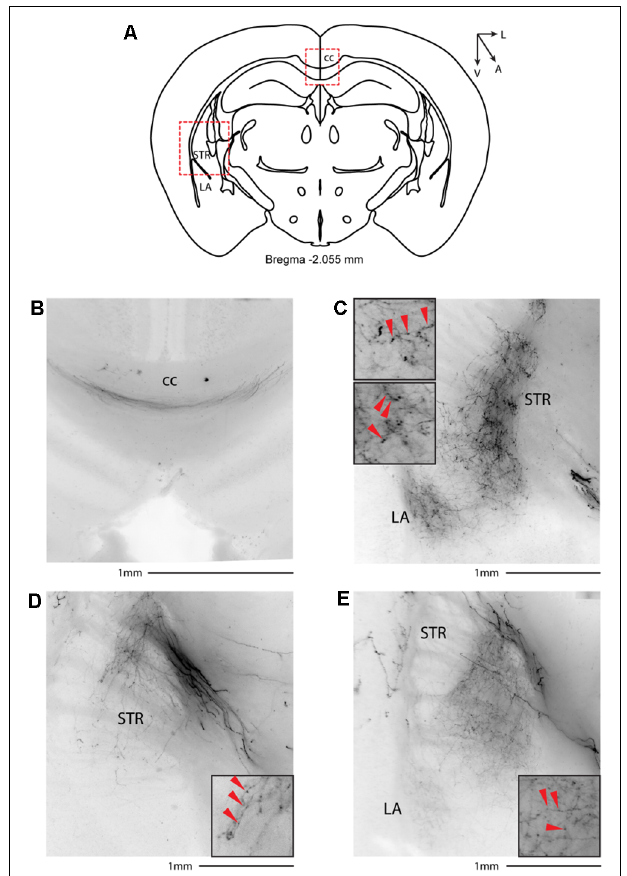
FIGURE 7 | Subcortical target of long-range VIP-expressing neurons: striatum. (A) Allen Brain reference coronal section at − 2.055 mm from Bregma. Red dashed squares indicate the regions imaged in the panels below. (B) Thick axons of passage in the corpus callosum. (C–E) Three representative images of VIP axons in the striatum and lateral amygdala from two animals. Scale bars: 1 mm. Insets indicate axonal branches and the red arrowheads boutons. Inset size 190 µ m. cc, corpus callosum; STR, striatum; LA, lateral amygdala.